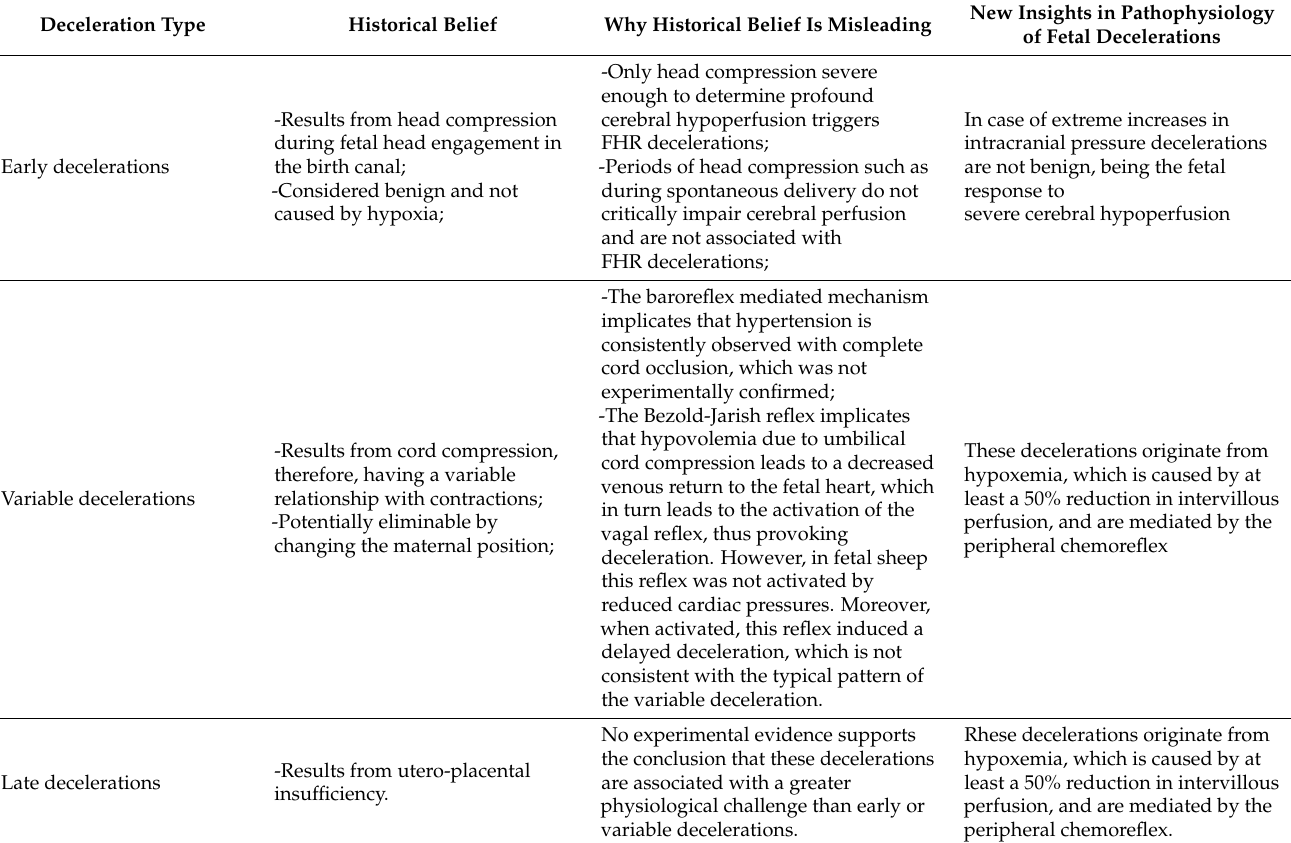
Table 2. Old versus new physiologic perspective on fetal